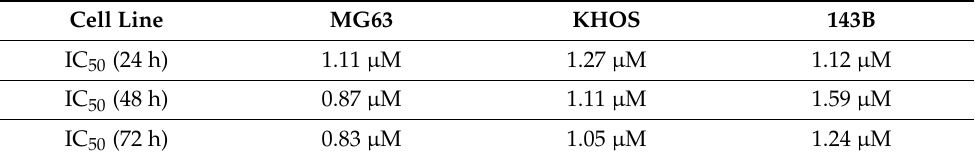
Table 1. Inhibitory Concentration 50 (IC 50 ) of ICG-001 in KHOS, MG63 and 143B